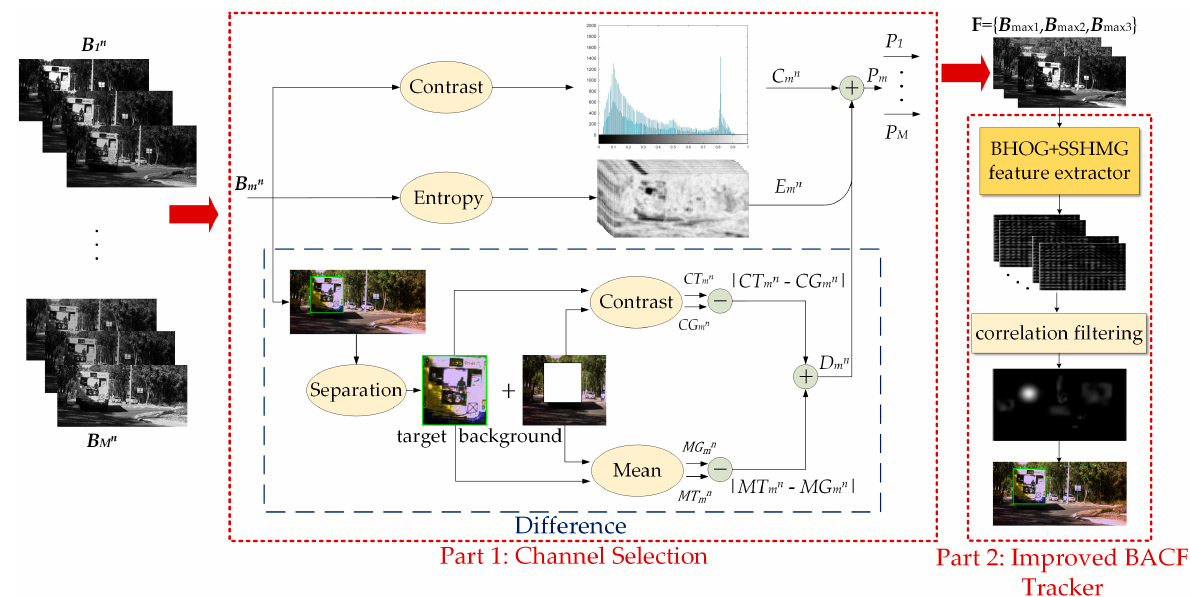
Figure 1. The architecture of the proposed method. The method mainly consists of two parts—Part 1: Channel Selection, and Part 2: Improved BACF Tracker. Part 1 is mainly composed of contrast module, entropy module, and difference module. Channel Selection is responsible for selection of the most representative few candidate channels from the input hyperspectral video. Part 2 is used to track the object in the images of the selected channels F . In Part 2, BHOG + SSHMG is designed to improve the classical BACF tracker.